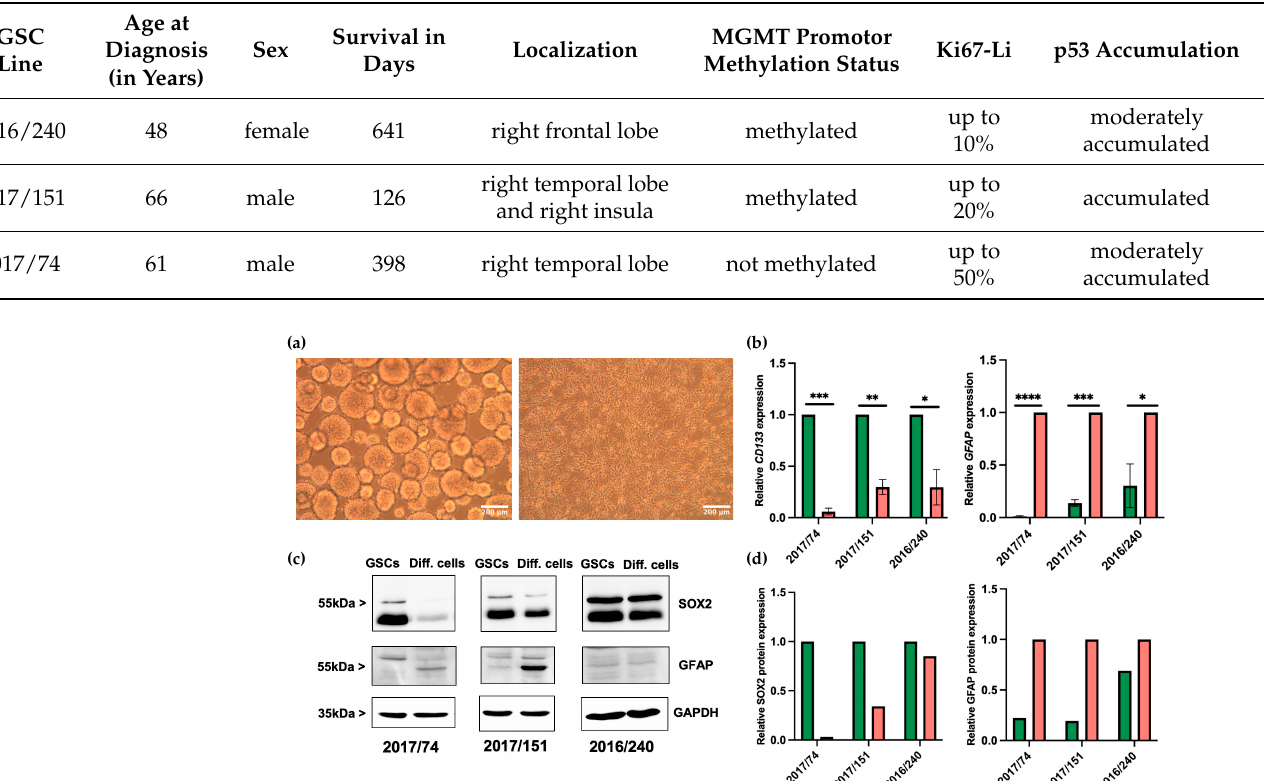
Table 1. Clinical information and histopathological characteristics of patient-derived GSC lines. All